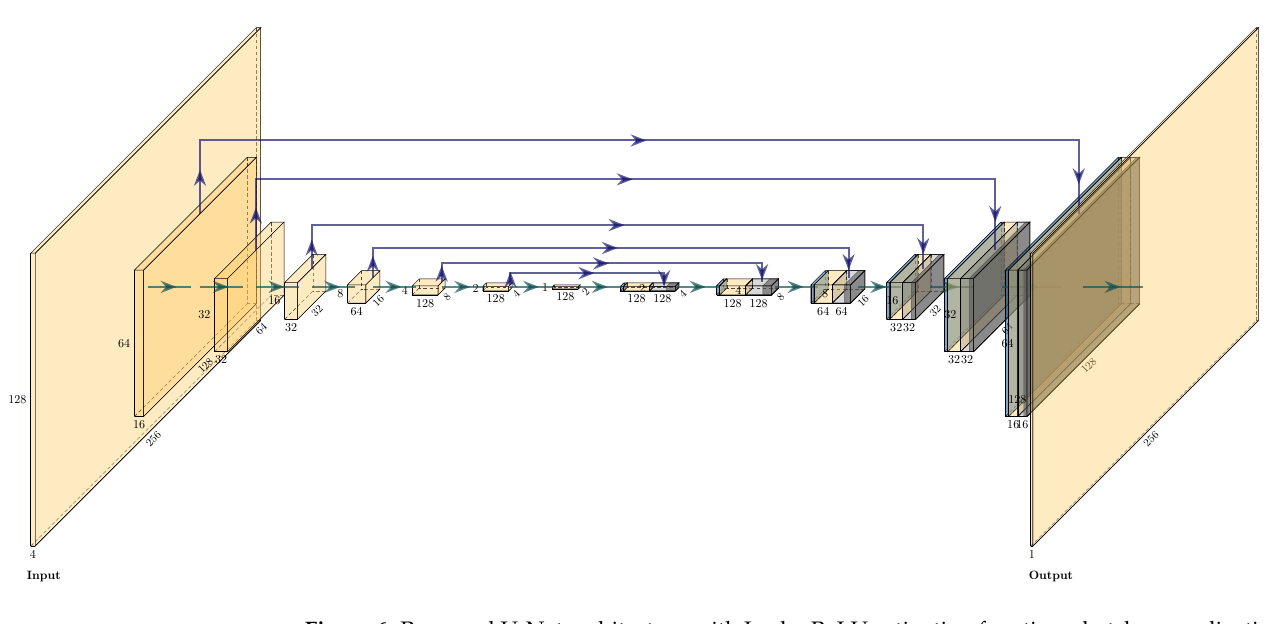
Figure 6. Proposed U-Net architecture with Leaky ReLU activation functions, batch normalization, upsampling layers, and skip connections. The inputs consisted of a tensor with 4 channels, each of 128 × 256, and the output was a single channel of 128 ×